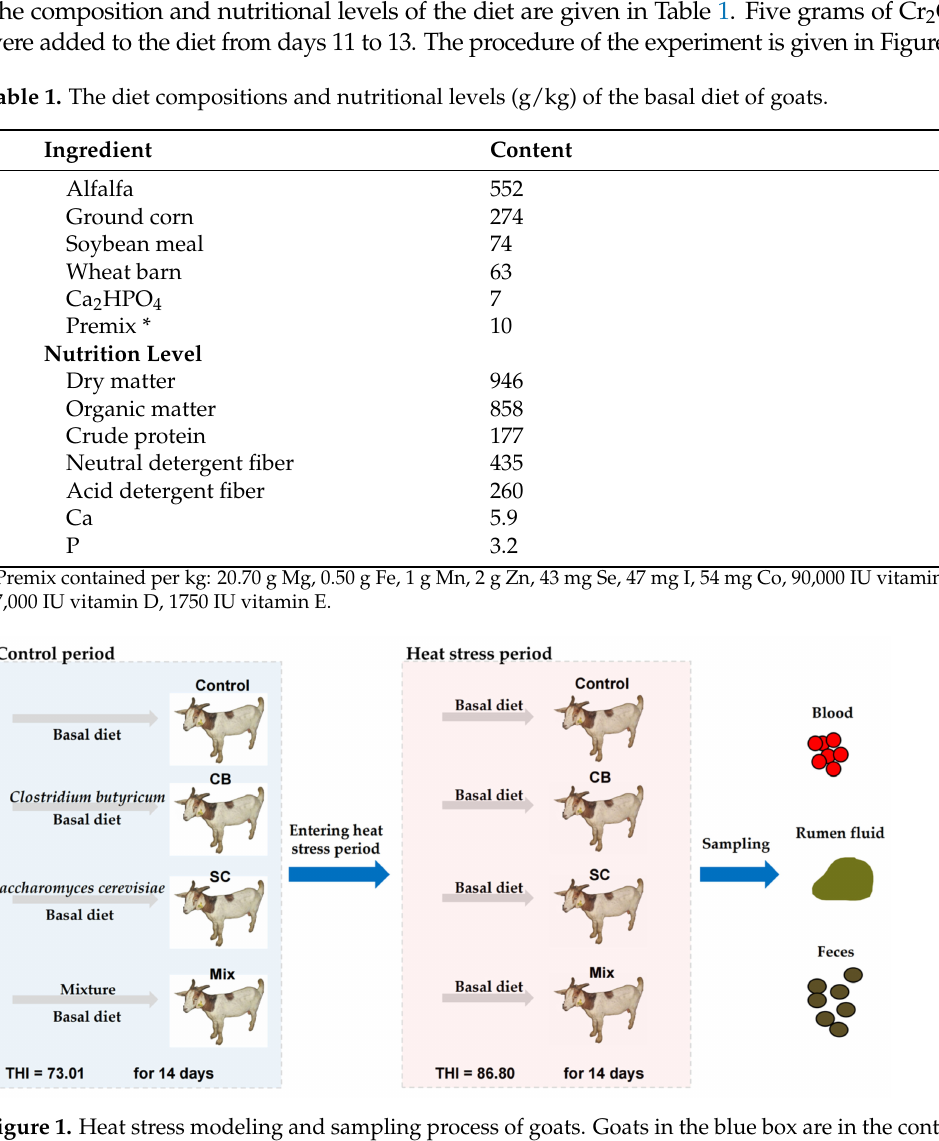
Figure 1. Heat stress modeling and sampling process of goats. Goats in the blue box are in the control period, where the environmental temperature humidity index (THI) was 73.01, and goats were in this environment for 14 days. Goats in the red box mean them in the heat-stressed period, in which the environmental temperature humidity index (THI) was 86.80, and goats in this environment for 14